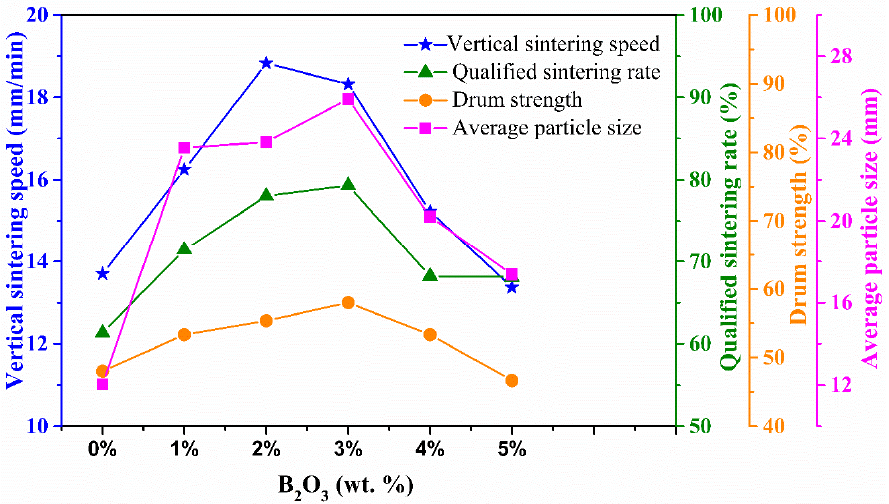
Figure 3. Key sinter properties with different additions of B 2 O 3